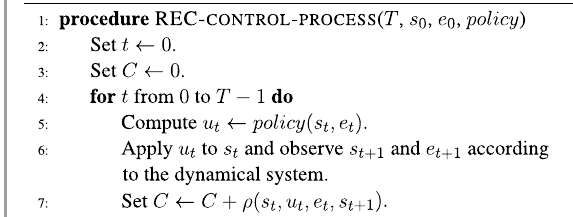
Algorithm2. RECcontrolprocesswithagivenpolicy.